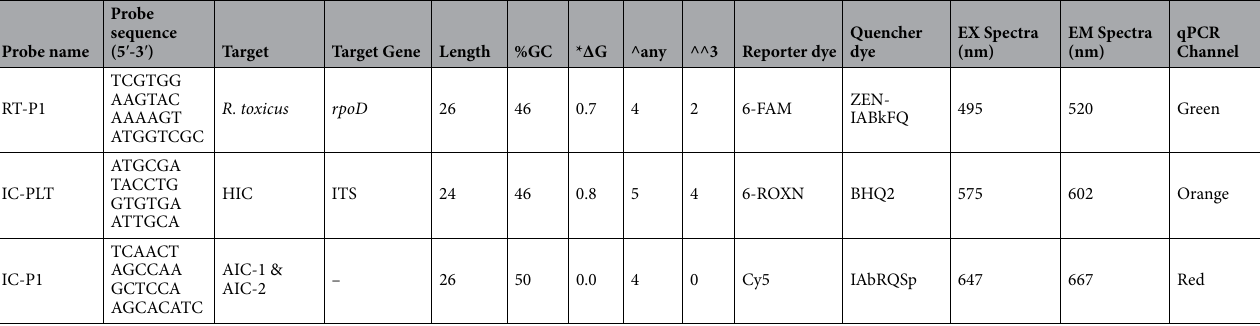
Table 3. Characteristics of probes used in detection assays of Rathayibacter toxicus , host Lolium rigidum (host internal control) and plasmid DNA (artificial internal controls). *Plot ΔG value in kcal/mol calculated by mFOLD; ^max self-complementarity; ^^max 3 ′ self-complementarity; rpoD —RNA polymerase sigma factor rpoD; BHQ2-Black Hole Quencher 2; IAbRQSp- Iowa Black RQ-Sp; IABkFQ-Iowa Black FQ; HIC-host internal control; AIC-artificial internal control.